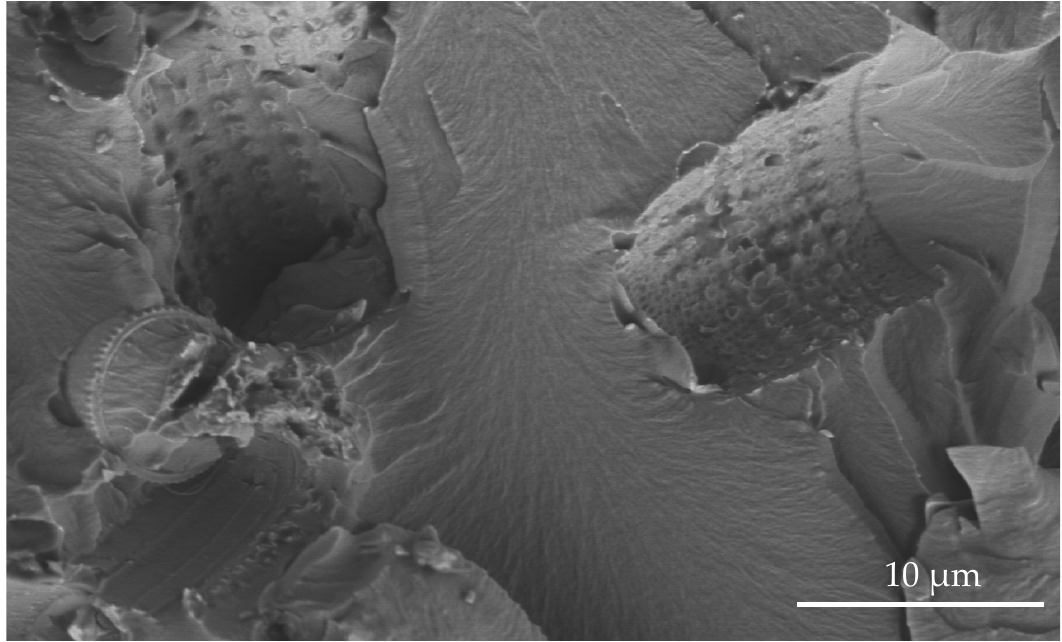
Figure 28. SEM image of diatoms filled with resin ( right ) and the mark after diatom debonding ( left ).